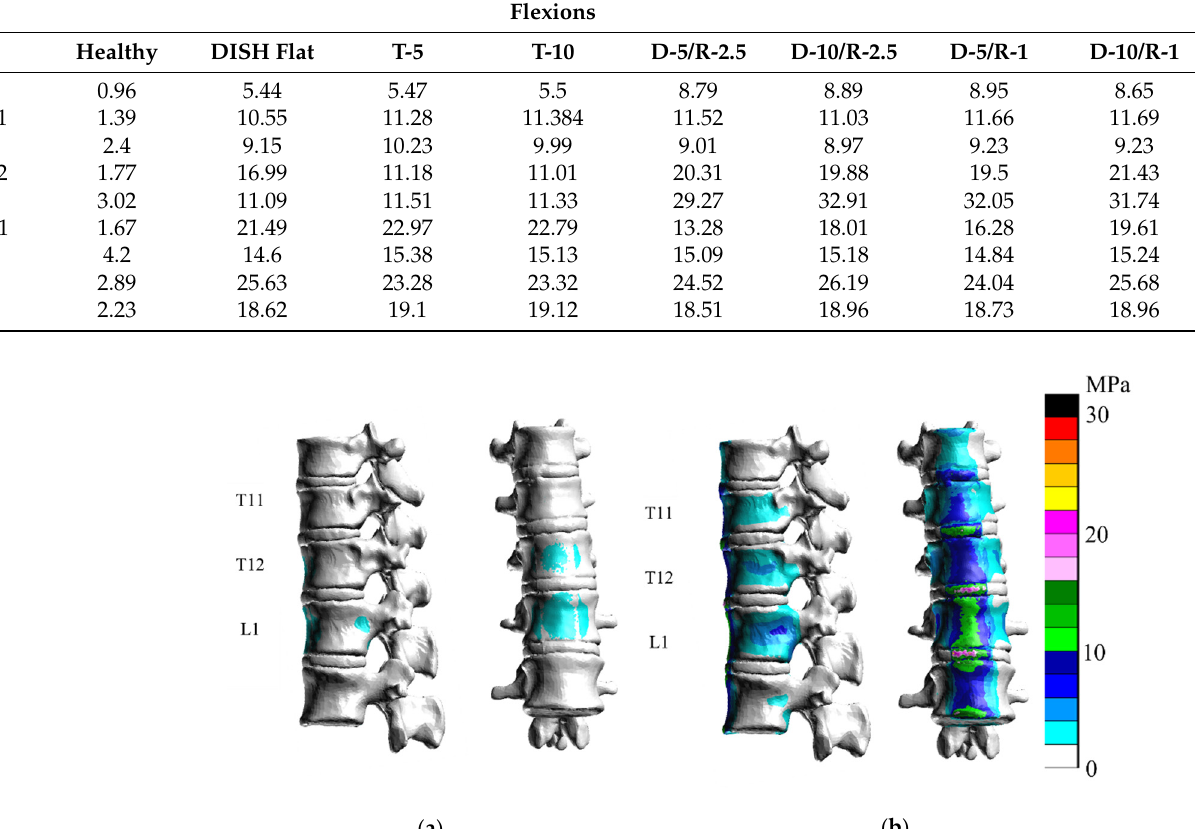
Figure 9. In D-5/R-1 ( a ) and D-10/R-1 ( b ), the stress at the center of T12 increased at the discontinuity in extension.